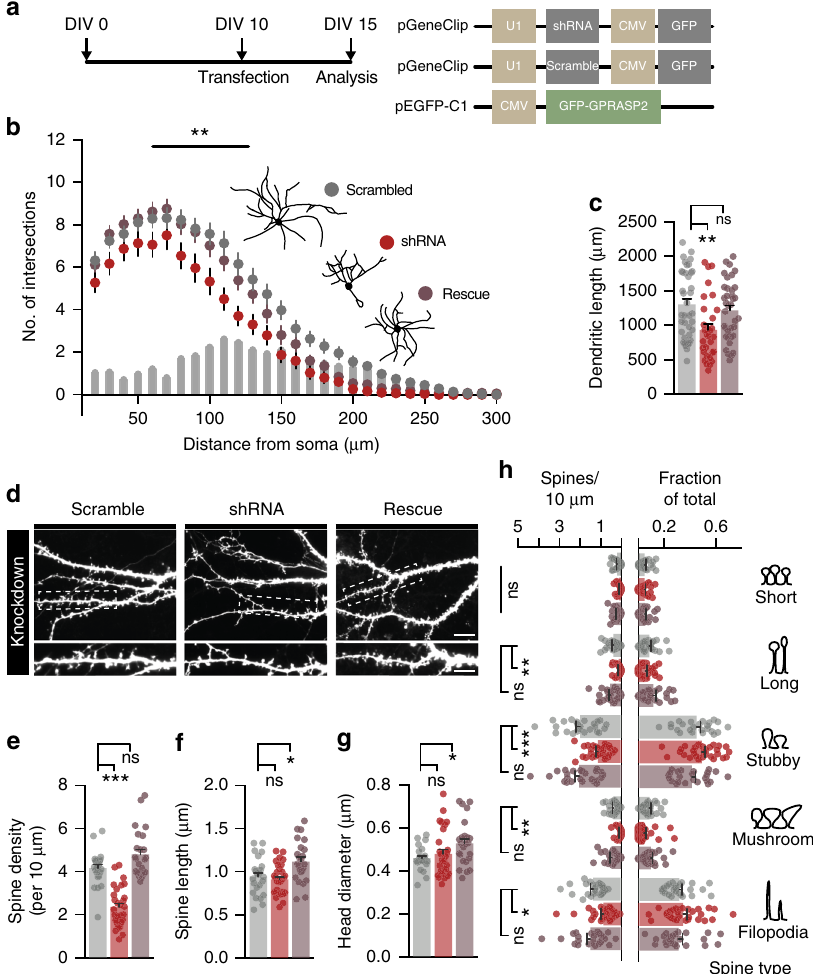
Fig. 4 Cell-autonomous reduction in dendritic complexity and spine density in acute GPRASP2 knockdown. a Cultured hippocampal neurons were transfected with scramble shRNA (Scramble), shRNA against Gprasp2 (shRNA) or GFP-GPRASP2 + shRNA (rescue) at DIV10 and analysed at DIV15. b Sholl analysis reveals reduced dendritic complexity in shRNA transfected neurons when compared with Scramble (effect of treatment ** p <